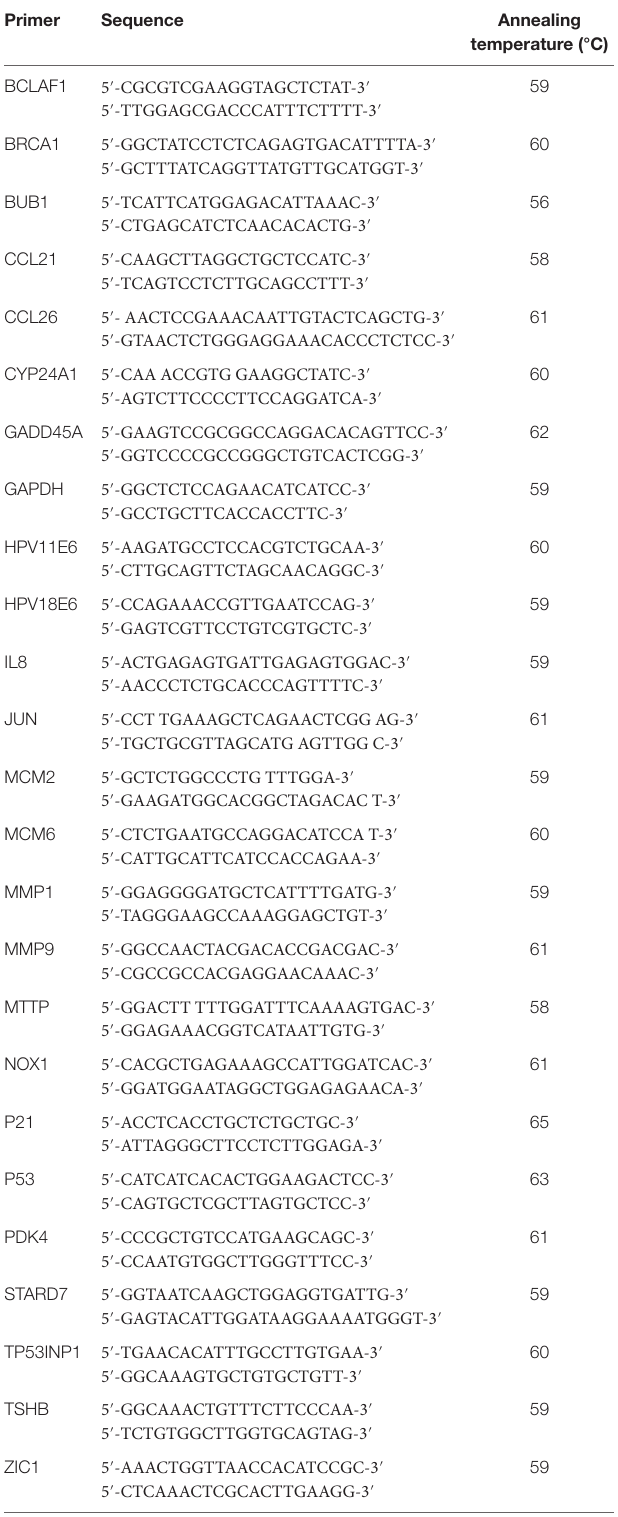
TaBle 4 | Primer sequences and annealing